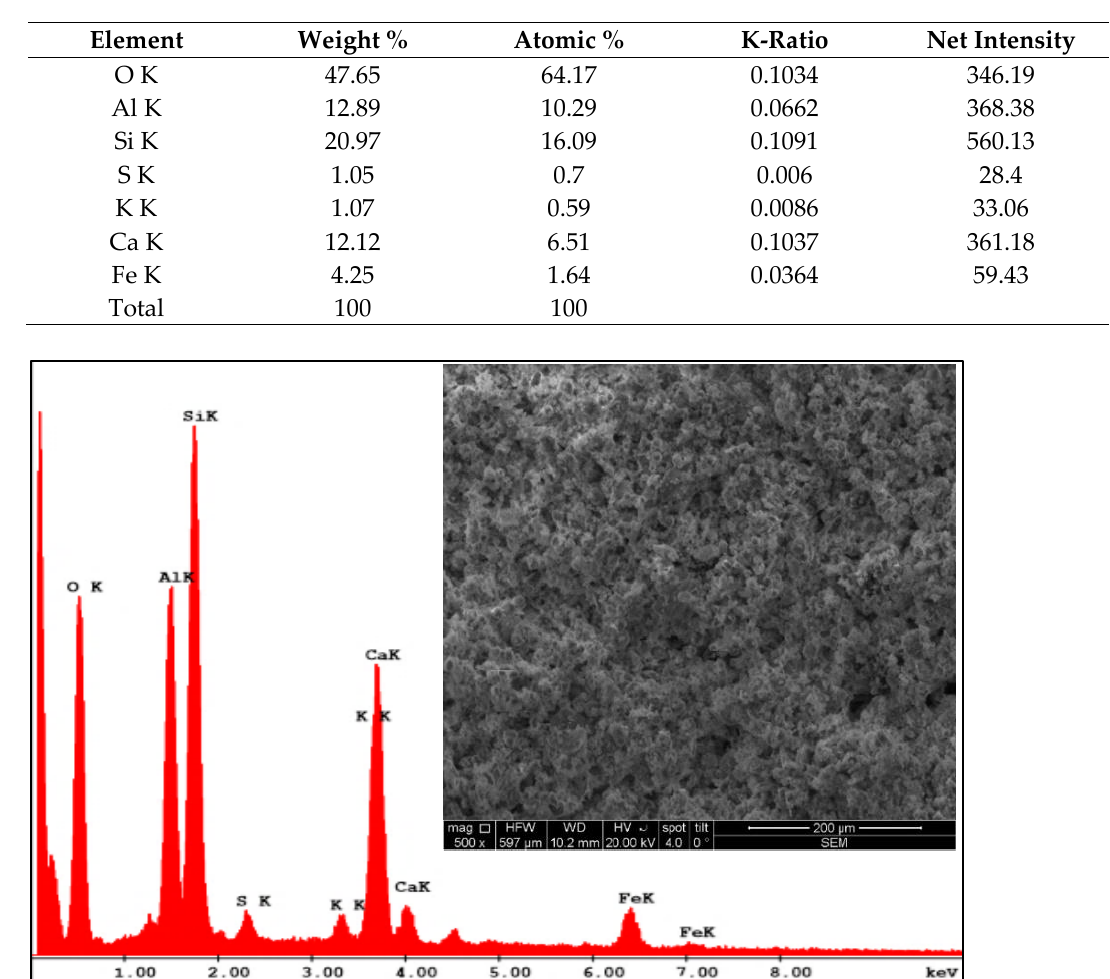
Figure 9. Elementary chemical analysis of CEM II/A-LL cement and SEM image of particles at a magnification rate of 500×.